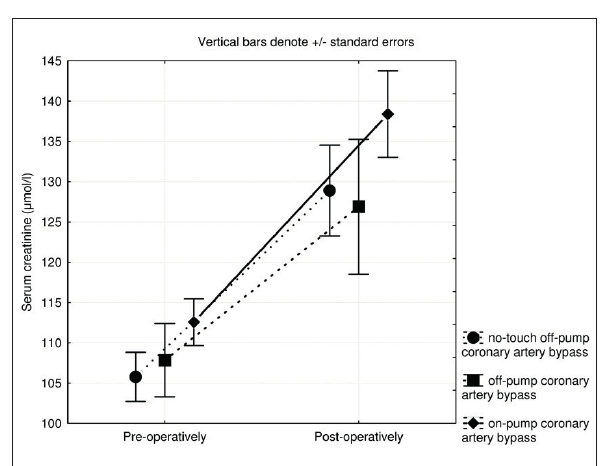
Fig. 1. Maximum creatinine value postoperatively. Pre- and post-operative serum creatinine levels difference in CABG, OPCABG and NOTOUCH group. A slight trend can be seen as well where the CABG patients had higher values compared to the other groups ( P =0.12)